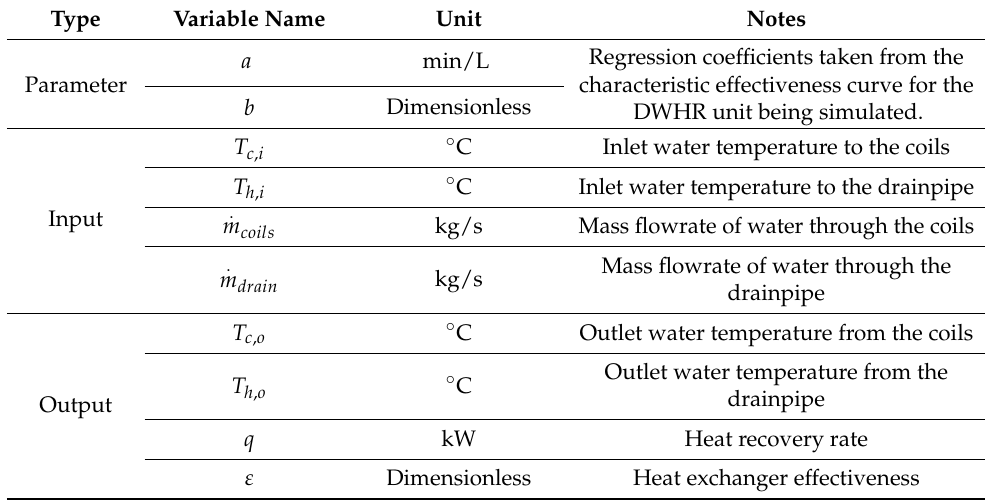
Table 1. Parameters, inputs, and outputs associated with the DWHR component created in Transient System Simulation Tool (TRNSYS) software.